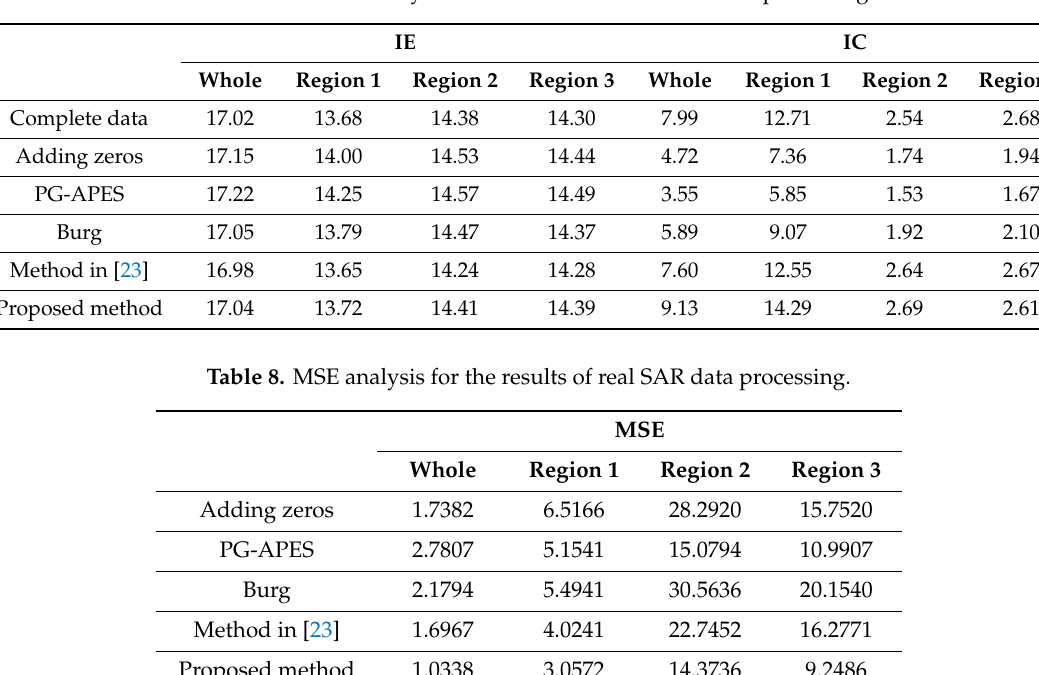
Table 7. IE and IC analysis for the results of real SAR data processing.